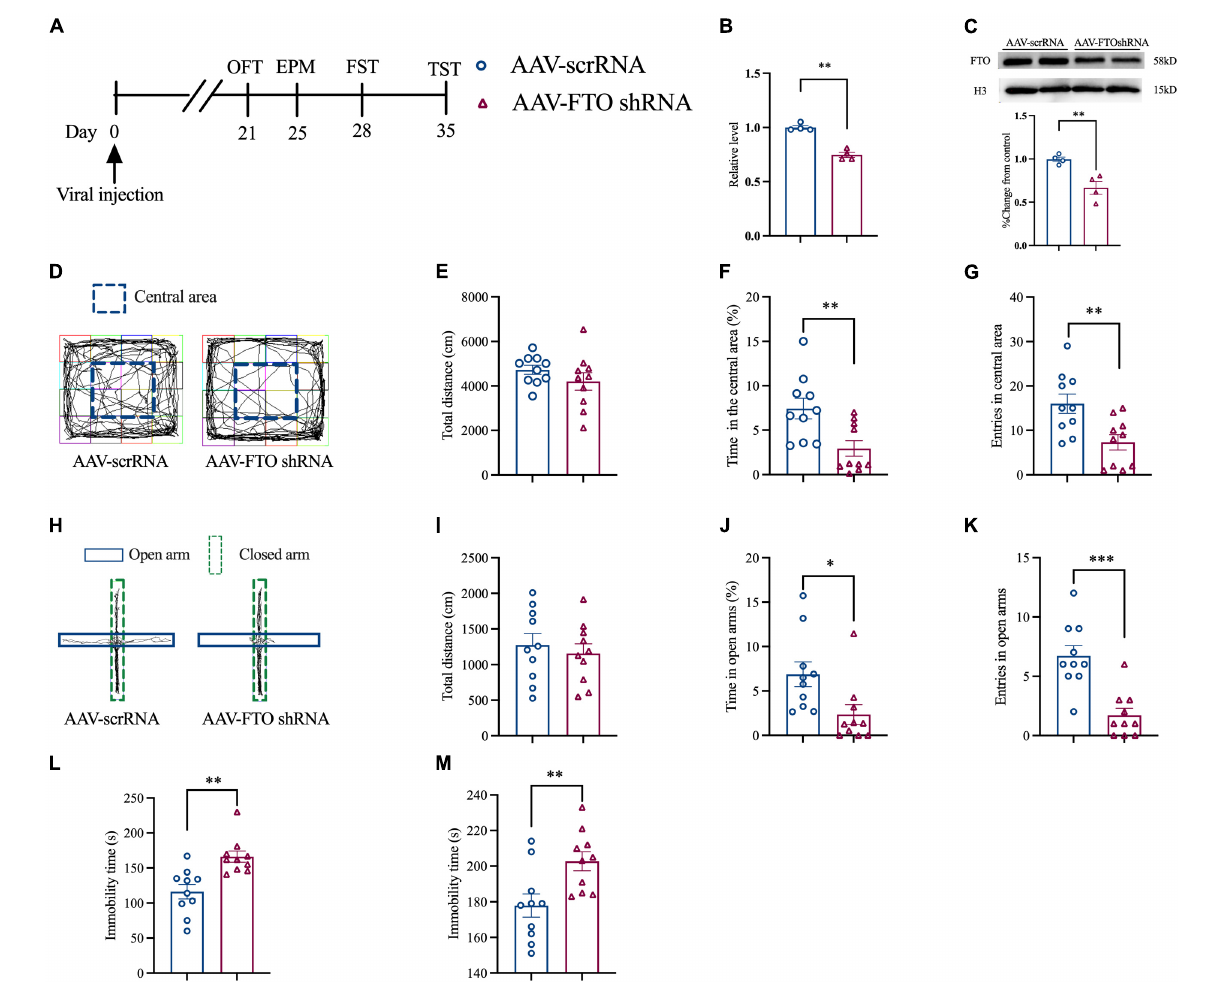
FIGURE 4 | Knockdown FTO in ACC induced anxiety- and depression-like behaviors in naive mice. (A) The schematic diagram of the experimental arrangement. (B,C) qRT-PCR and Western blot results of the expression of FTO mRNA and protein in naive mice 21 days after transfection with AAV ( ∗∗ P < 0.01, ∗∗∗ P < 0.001 vs. AAV- scrRNA). (D) OFT trajectory. (E) total movement distance during OFT. (F) Percentage of residence time in the central area during OFT ( ∗∗ P < 0.01 vs. AAV- scrRNA). (G) The number of entering the central area during OFT ( ∗∗ P < 0.01 vs. AAV- scrRNA). (H) EPM trajectory. (I) Total movement distance during EPM. (J) Percentage of exploration time in open arm during EPM ( ∗ P < 0.05 vs. AAV- scrRNA). (K) The number of mice entering the open arm during EPM ( ∗∗∗ P < 0.001 vs. AAV- scrRNA). (L,M) Immobility time of FST and TST ( ∗∗ P < 0.01 vs. AAV-